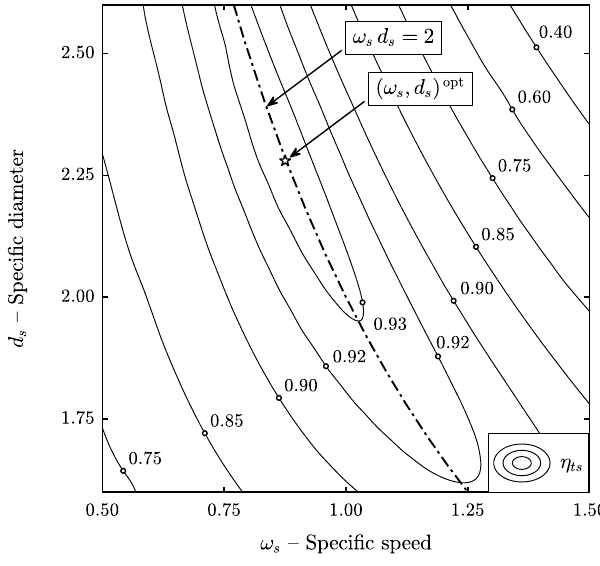
Figure 7. Balje diagram of the reference